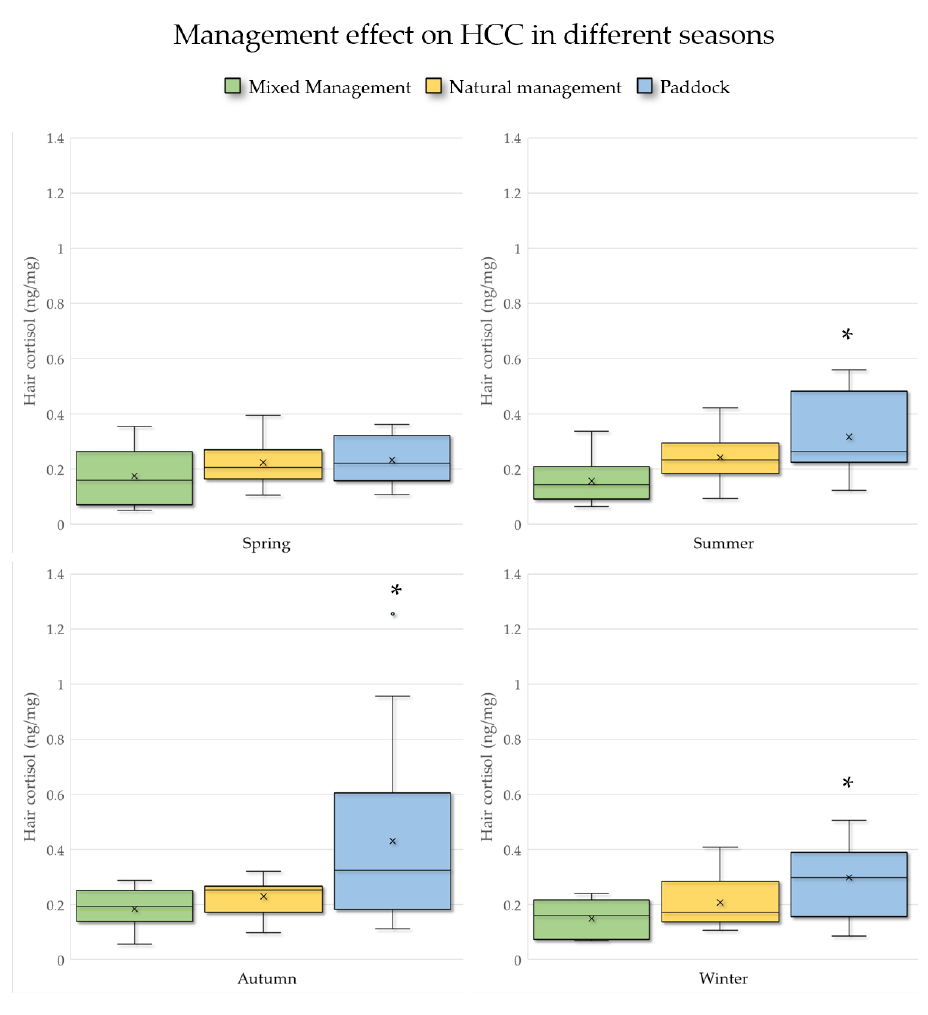
Figure 1. Box plots of the horsehair cortisol (HCC) levels in the different management conditions, in each season, for all the included horses ( n = 47). * = significantly higher values. p ≤ 0.05 was considered statistically significant.